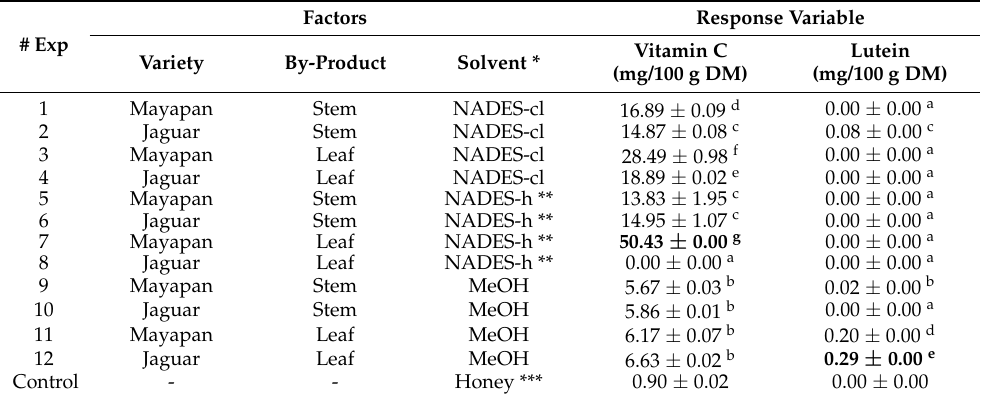
Table 3. Vitamin C and lutein content of extracts obtained by ultrasound from habanero pepper by-products ( Capsicum chinense